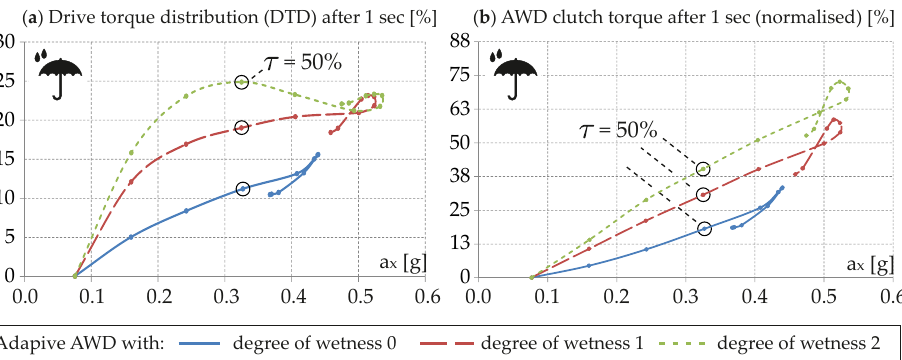
Figure 11. “Power On Cornering“ maneuver ( R = 60m , a y 0 = 6m/s 2 ) on wet road ( µ max = 0.6): ( a ) drive torque distribution (DTD) after 1s; ( b ) normalised AWD clutch torque after 1s.